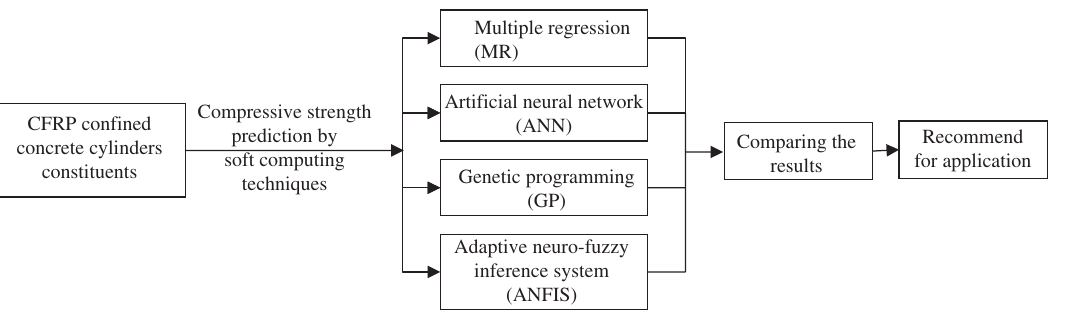
Figure 1 Overview of the